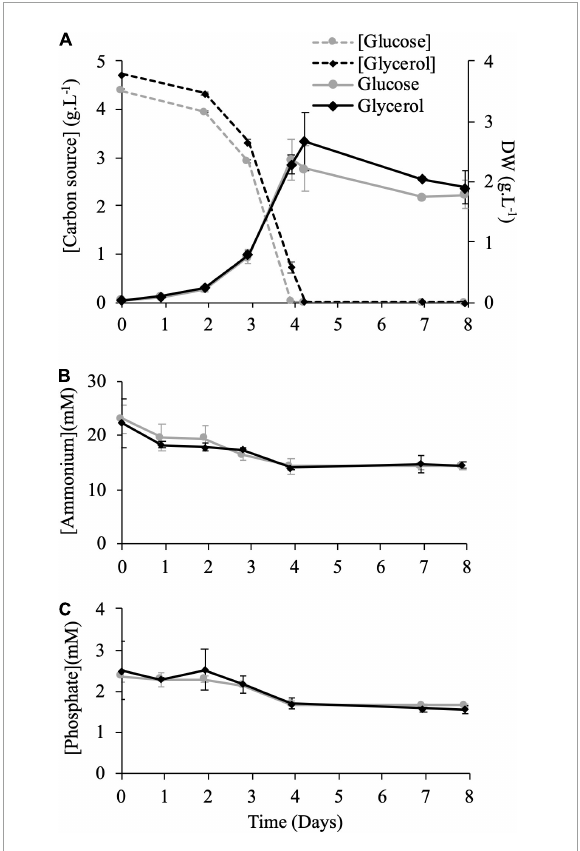
FIGURE1 Biomass dry weight and nutrient concentrations in the medium of Galdieria sulphuraria cells grown in heterotrophy in the presence of glucose or glycerol as carbon source. (A) Dry Weight (DW) evolution (solid lines, secondary axis) and carbon source concentration in the medium (dashed lines, primary axis) over time (days). Glucose: gray circles; Glycerol: black diamonds. Data are expressed in g.L − 1 of culture. Graphs (B,C) show ammonium and phosphate concentrations in the culture in mM over time (days). Data are presented as means of three independent biological replicates. Error bars represent standard deviation of the mean ( ±